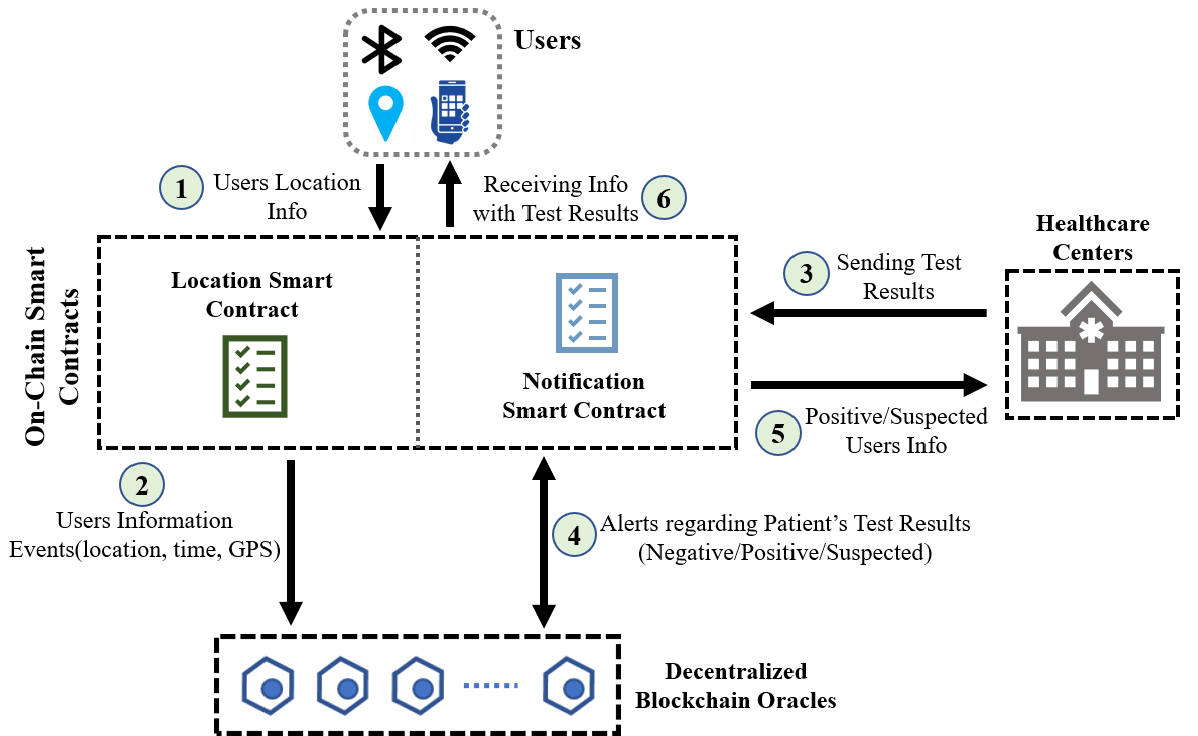
Figure 5. Proposed contract tracing solution using blockchain.